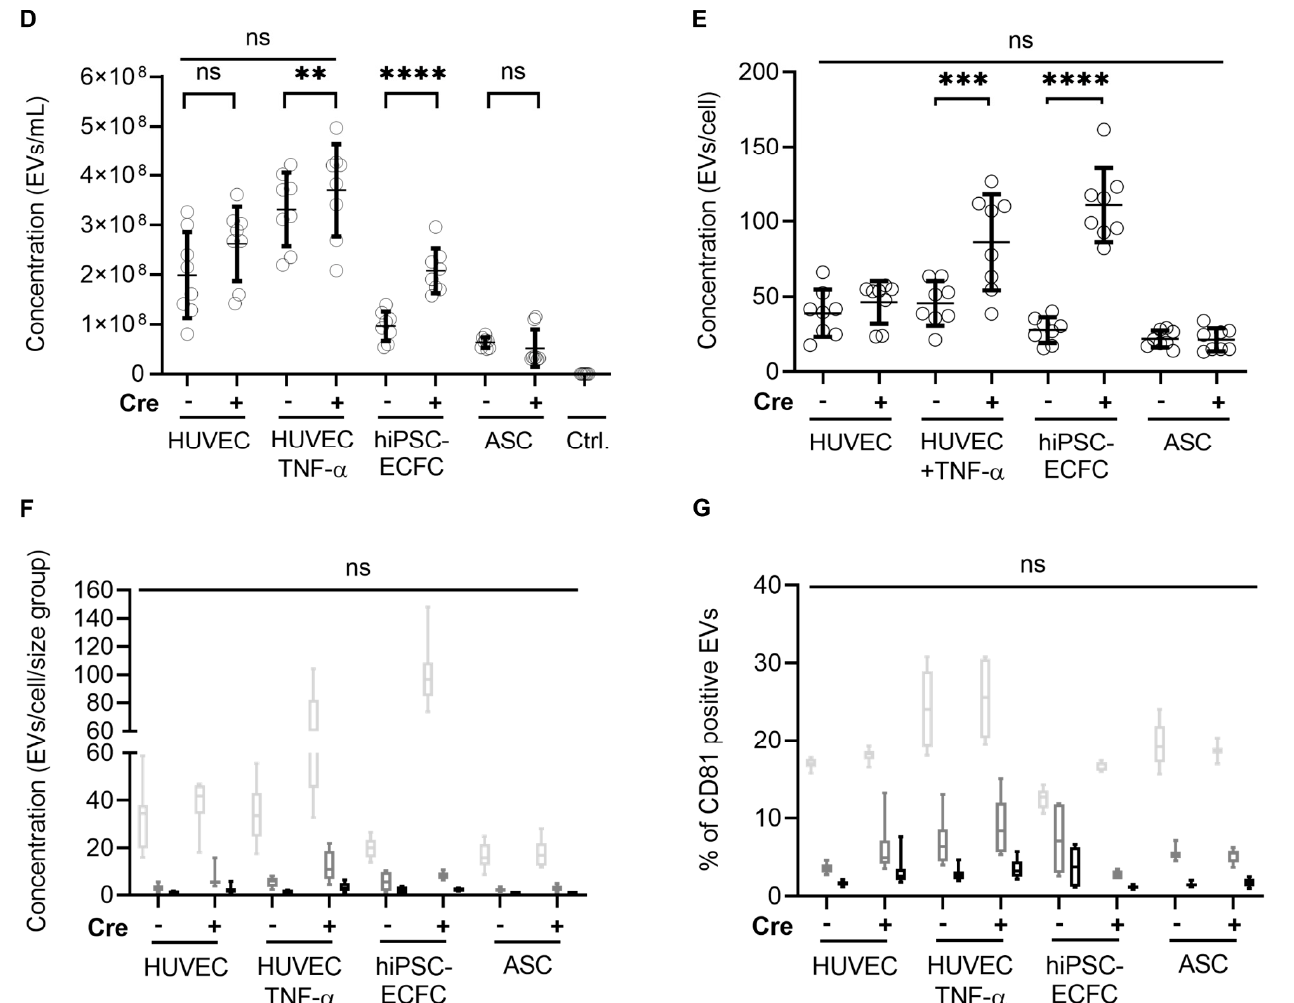
Figure 8. Comparison of extracellular vesicle (EV) release by HUVEC, hiPSC-ECFC, and ASC before and after retroviral transduction with the Cre construct via NTA and FT-FC. ( A ) Concentration (particle/mL) measured in scatter and fluores- cence mode NTA showing no significant difference between the different cell types and with or without Cre expression. ( B ) After normalization to cell number a significant difference between hiPSC-ECFC and hiPSC-ECFC Cre + in EVs (fluores- cence) release could be detected. ( C ) Calculation of the ratio of EVs (fluorescence mode) and particles (scatter mode) showed a significant difference between endothelial cells and ASC. ( D ) Concentration (particle/mL) measured using FT-FC shows no significant difference between the different cell types and with or without Cre expression. ( E ) After normalization to cell number a significant difference between EC and Cre expressing EC could be detected. ( F ) Size distributions of EVs, analyzed via FT-FC, show no significant difference between the cell types and with or without Cre expression. ( G ) Percentages of CMG-stained and CD81 labeled EVs in the different size ranges (light grey, grey, and dark grey) shows an increase in CD81 positive EVs (<200 nm) released by HUVEC after TNF- α stimulation. **** = p < 0.0001, *** = p < 0.001, ** = p < 0.01, ns = p > 0.05. Error bars indicate the mean values ± SD. Data was obtained from four independent experiments. n = 2 cell donors (HUVEC, ASC) and one cell donor